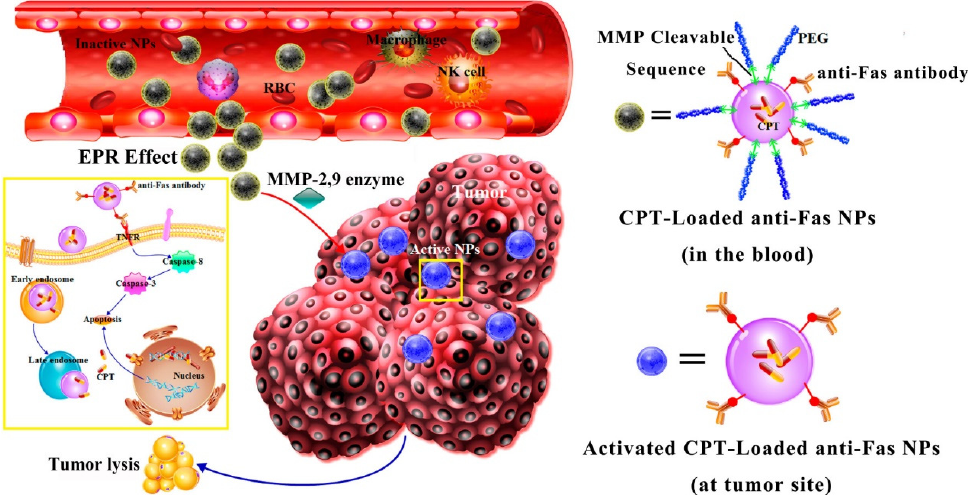
Figure 1. Schematic illustration of the structure of anti-Fas antibody-conjugated nanoparticles and the therapy strategy of nanoparticles against tumor cells. Reprinted with permission from Ref. [20]. Copyright 2016 American Chemical Society.